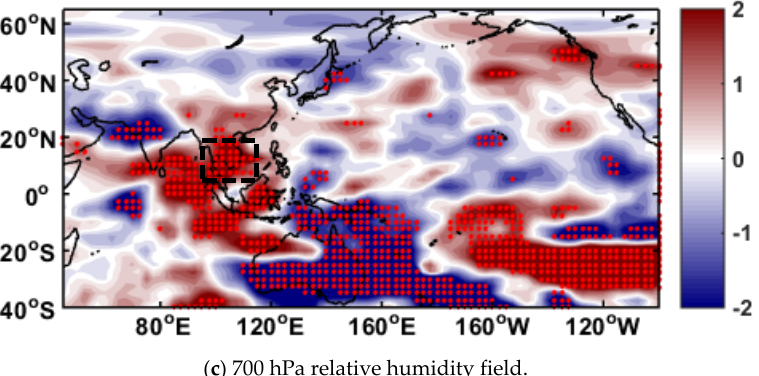
Figure 4. Regression maps based on EWI (the marked areas indicate statistically significant values at the 5% level).